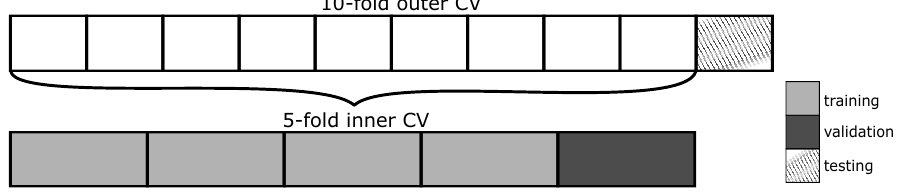
Figure 7. Illustration of the nested cross-validation